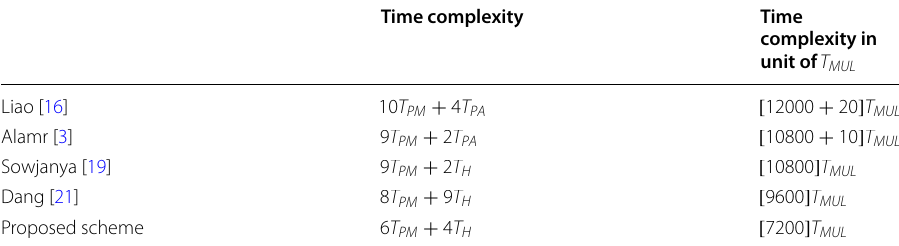
Table 8 Performance comparison of computation costs among related protocols in authentication